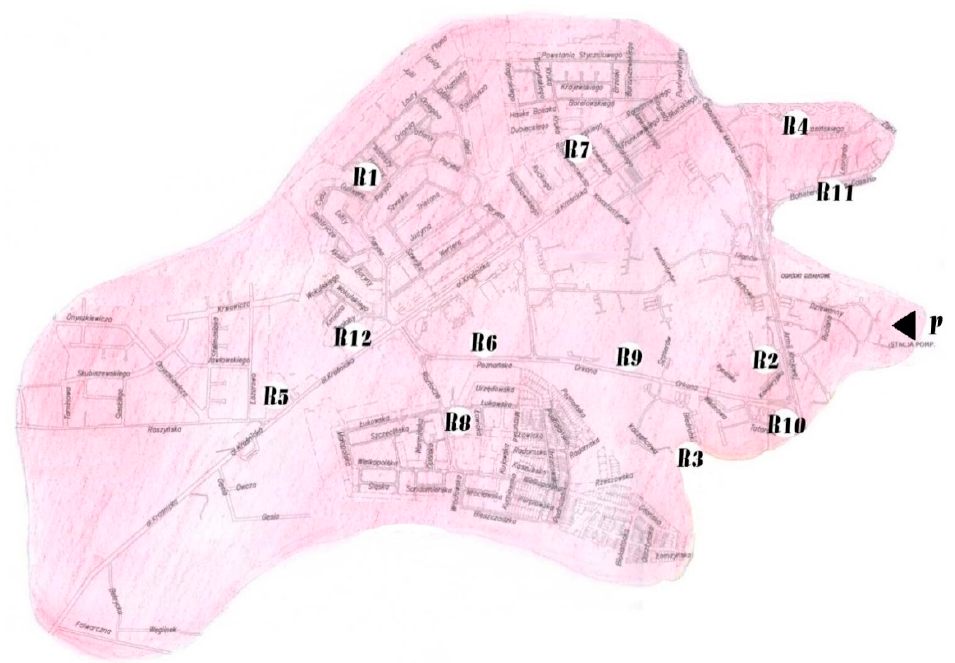
Figure 1. Distribution of water quality monitoring points in the analyzed area of the distribution system. R1, R2, ..., R12—points of water sampling for testing, ◄ P—supplying the zone with water (pumping station).